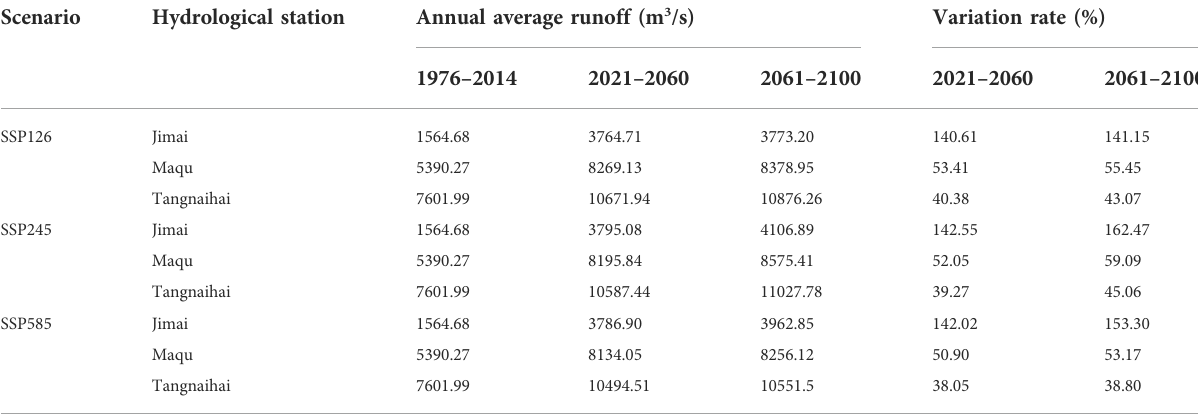
TABLE 6 Yearly average discharge and variation rate at three hydrological stations under different scenarios from 1976 to 2100. Scenario